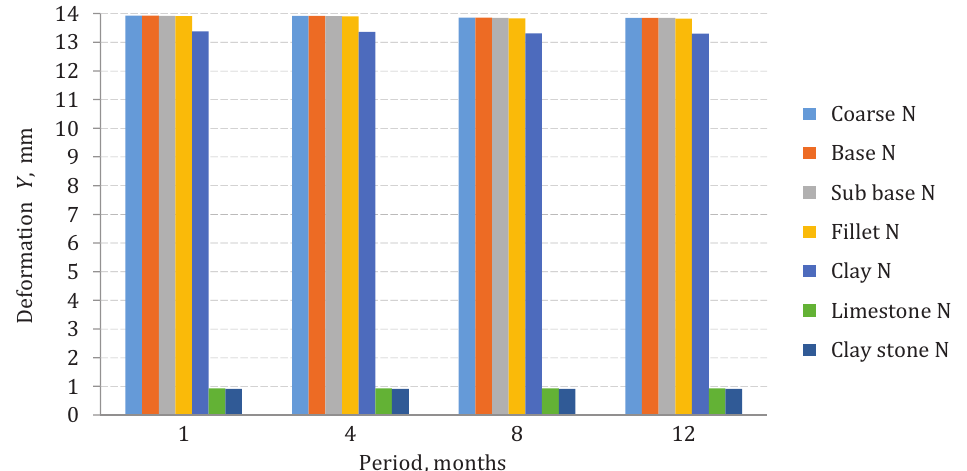
Figure 15. Vertical deformation ( y )-time changes of the layers for N